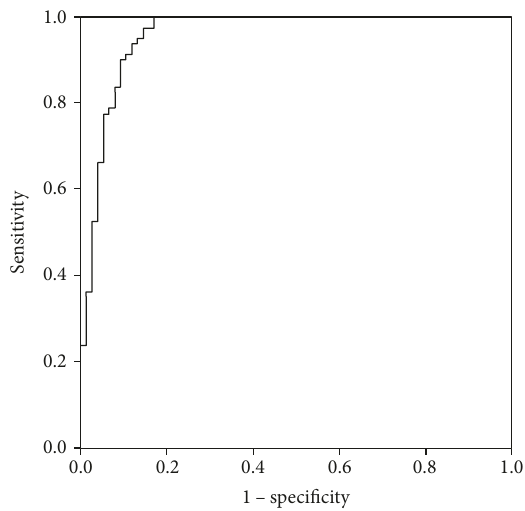
Figure 3: Receiver operating characteristic curve of sIL-2R as a predictor of group (CRPS patients versus healthy controls). Area under the curve 0.958 (SE 0.016), p < 0 001 .